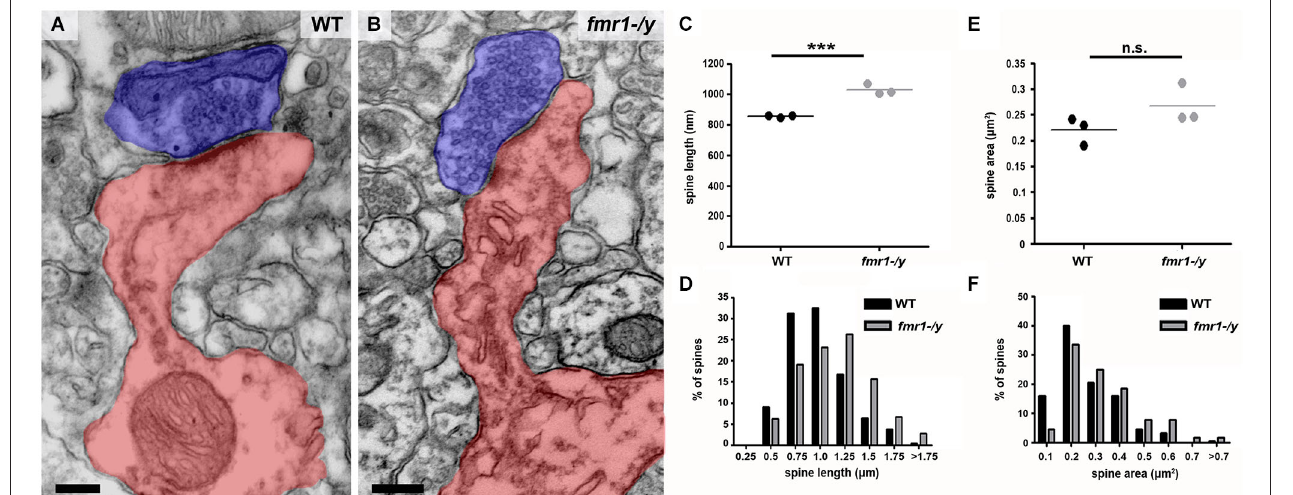
fmr1-/y spines reveals an increase in the number of long spines in fmr1-/y mice and a decrease in small spines compared to wild-type. Chi-squared test, p < 0.0001. Although the difference in the mean area of wild-type and fmr1-/y spines did not reach statistical significance (E) ; 3 WT v 3 fmr1-/y mice, unpaired t -test, p = 0.157), binning the data from all spines (221 WT v 224 fmr1-/y ), revealed a rightward shift in the data distribution, due to a higher incidence of larger spines in fmr1-/y compared to wild-type (F) . Chi-squared test, p =